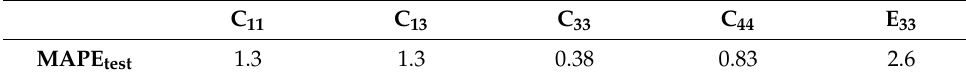
Table 4. Average evaluation of the results in the full parameter space.